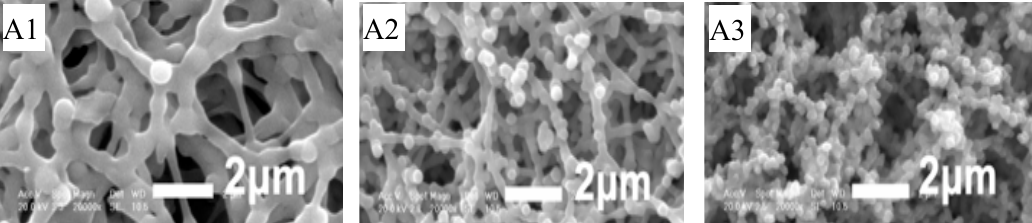
Figure 3 . Field emission gun scanning electron microscope (FEGSEM) image of the porous silica core layer deposited at different temperatures to make three preforms/fibers: ( A1 ) 1350 °C, ( A2 ) 1400 °C, and ( A3 ) 1450 °C.